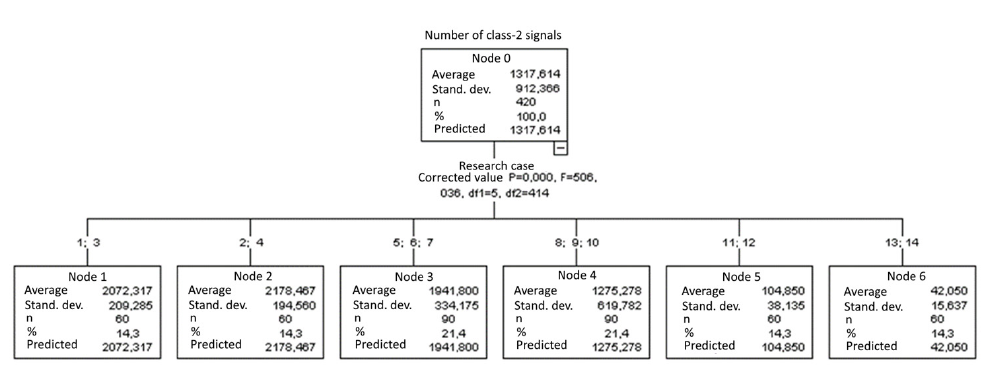
Figure 19. Classification tree for the number of class-2 signals.